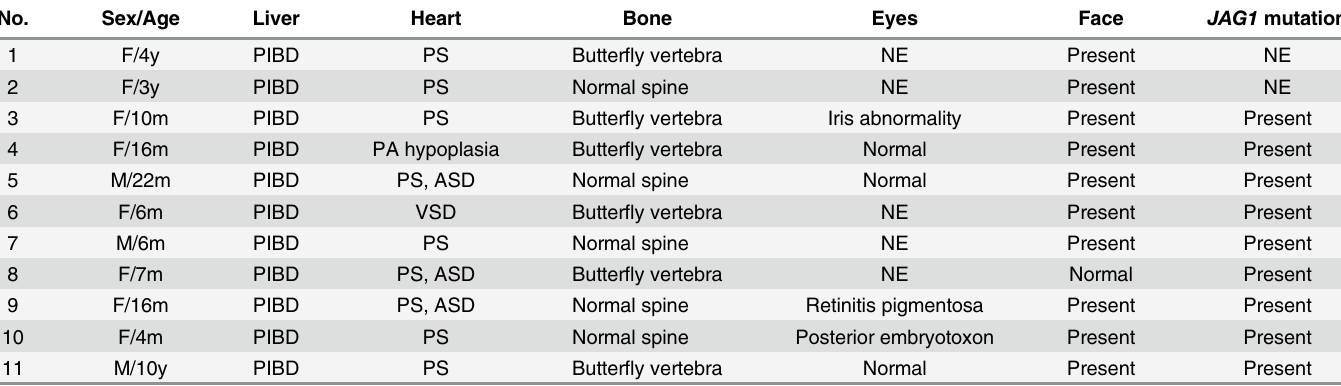
Table 2. Major clinical features and gene analyses in 11 patients with Alagille syndrome candidates for liver transplantation.